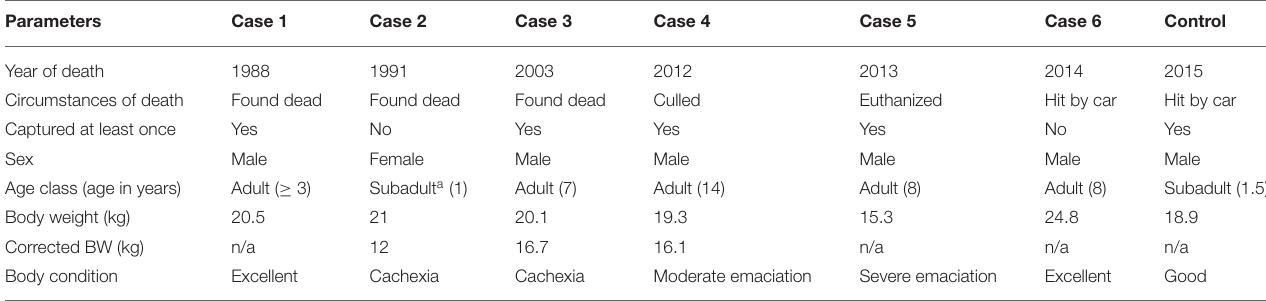
TABLE 2 | General information on six Eurasian lynx (subspecies Lynx lynx carpathicus ) from Switzerland affected by cardiomyopathy and one healthy individual (control) for comparison.